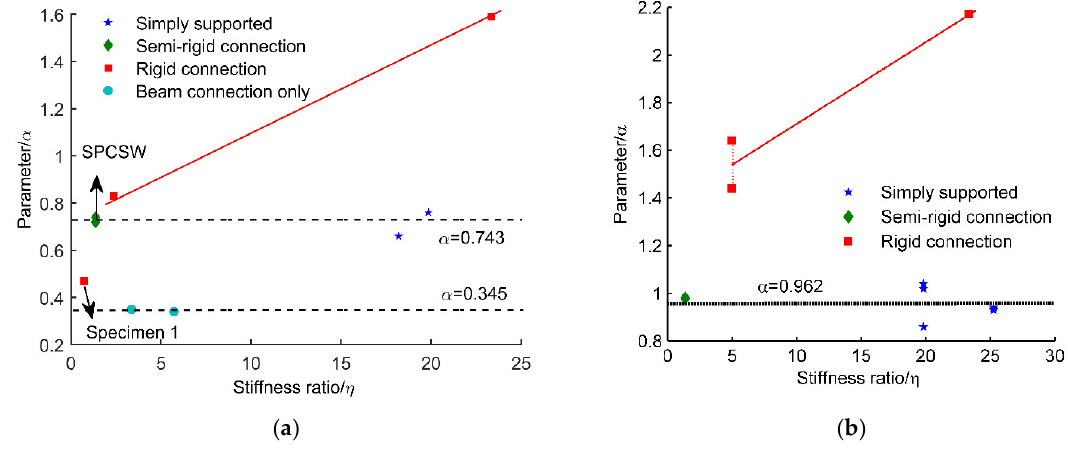
Figure 20. Relationship between parameter  and stiffness ratio  : ( a ) SPSW; ( b )